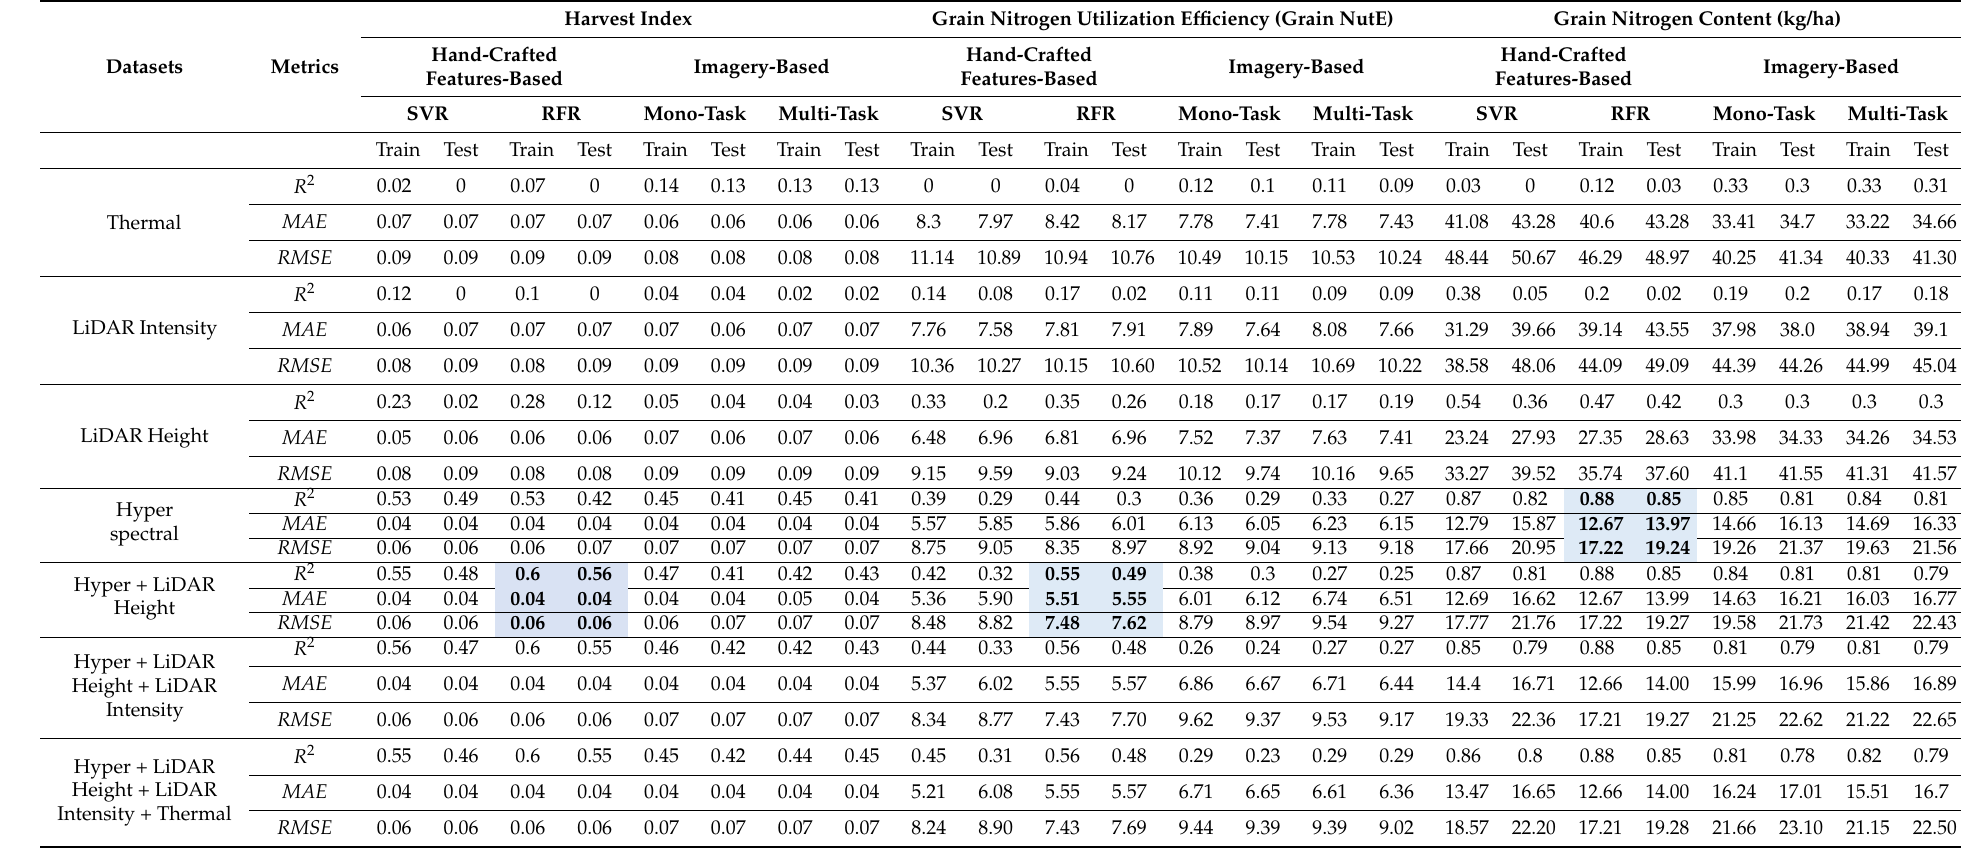
Table A2. Results of maize phenotypic prediction performed by different data sources and regressors (cont.).